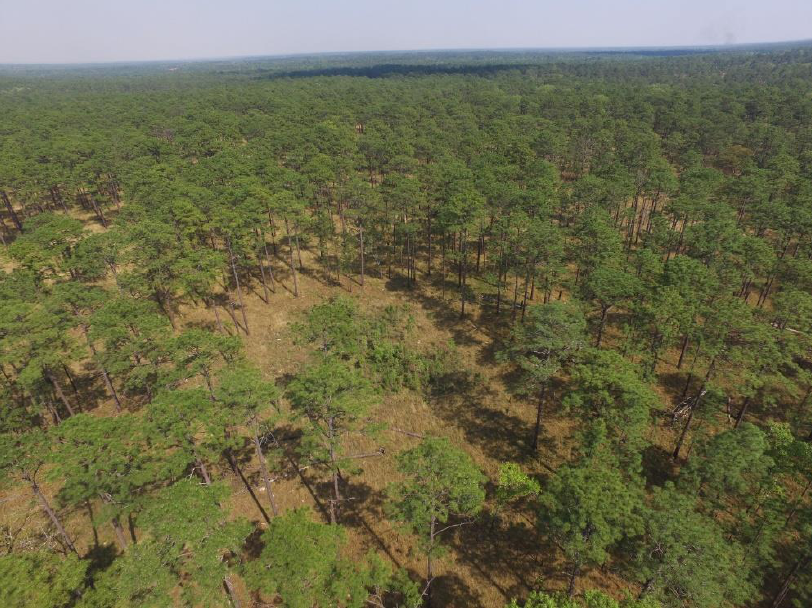
Figure 2. Patchy longleaf pine savannah ecosystem from above (photograph by Andrew Whelan, Jones Ecological Research Center).